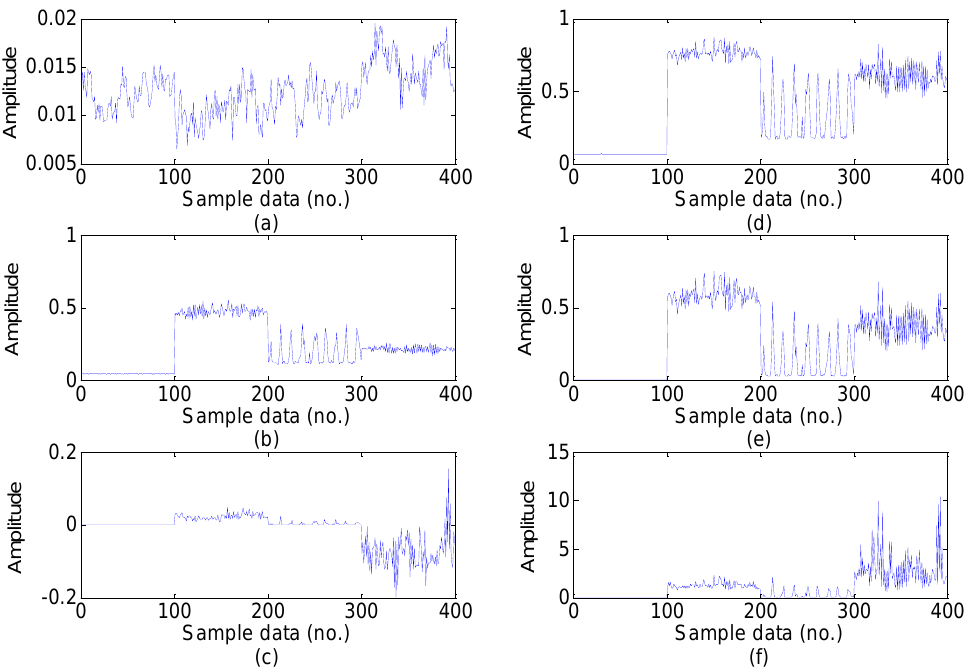
Figure 5. The six dimensional time-domain features value in the dataset: ( a ) Mean; ( b ) Root mean square; ( c ) Root; ( d ) Standard deviation; ( e ) Skewness; ( f ) Kurtosis (Note: sample data No.1–100, 101–200, 201–300, 301–400, represent normal, inner race fault, ball fault and outer race faults, respectively).